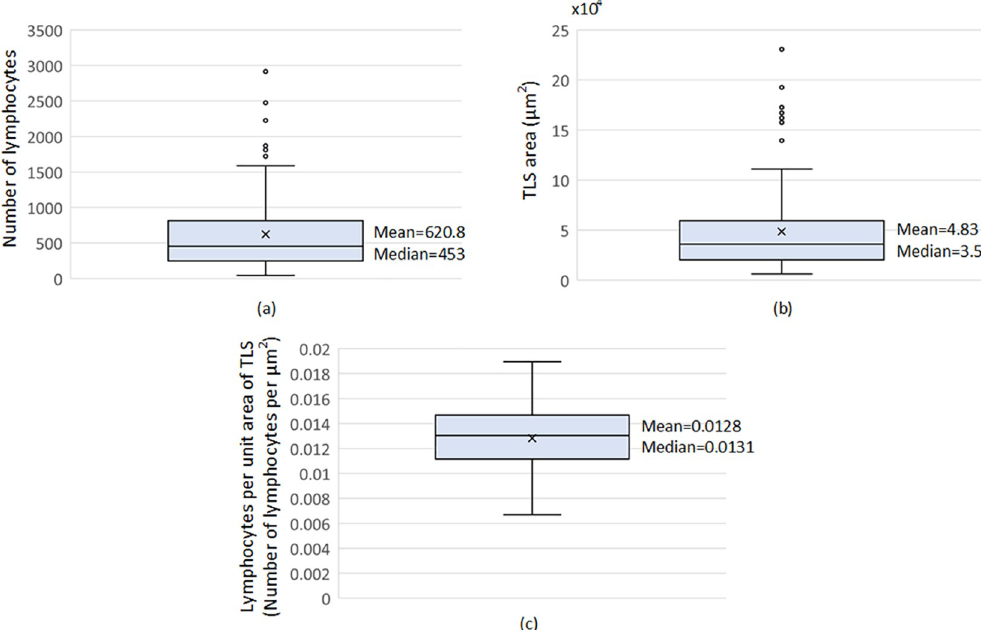
Fig 7. Box plots for (a) the number of lymphocytes, (b) size and (c) density (number of lymphocytes per unit area of the TLS regions) for the hematoxylin and eosin (H&E) stained histological slides included in both of D1 & D2.